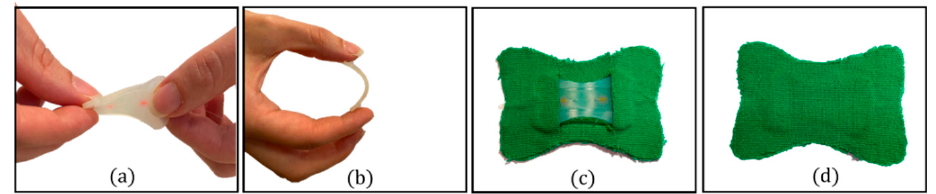
Figure 6. ( a ) Twisting and ( b ) bending of the silicone layer embedding the FBG sensor; ( c ) the smart patch backend and ( d ) frontend.